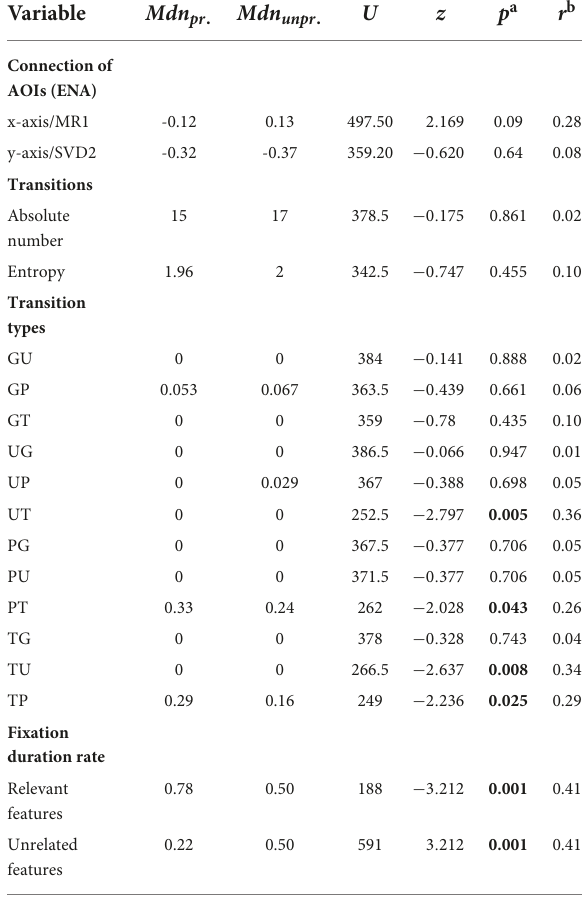
TABLE 1 Results of the Mann–Whitney U test for different eye-tracking data comparing the construction of productive and unproductive